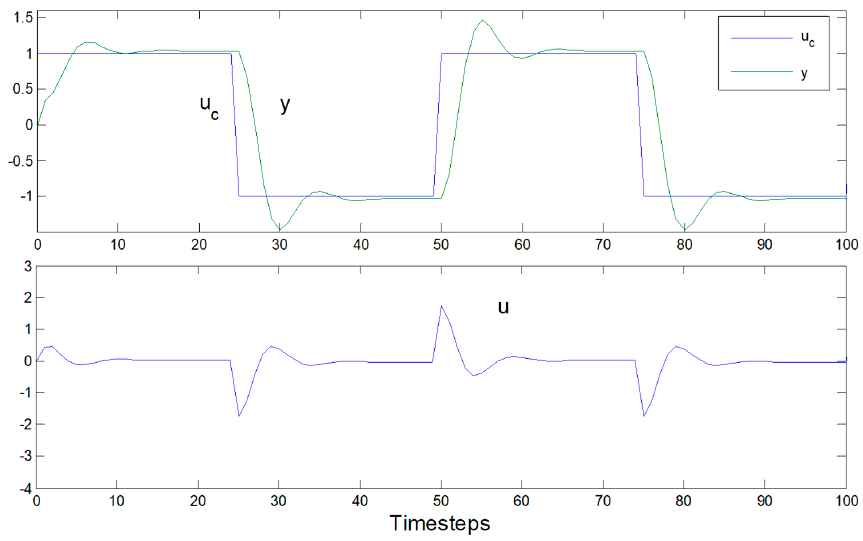
Figure 10 . Control u ( t ) output y ( t ) versus time Direct Self-Tuner with increase pole excess d 0 = 2: Note elimination of the control “chattering”.